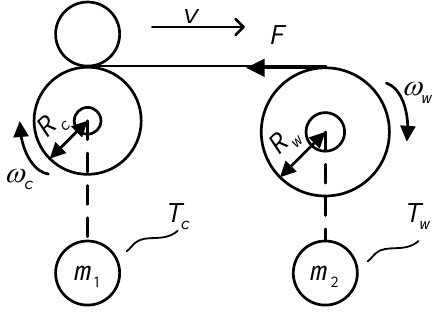
Figure 2. Diagram of the winding system structure.